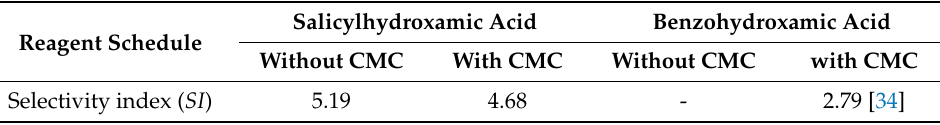
Figure 5. Froth phase images of mixed binary mineral flotation experiments after 0 ( a ) and 3 min ( b ) flotation. Table 1. Selectivity index ( SI ) values in different flotation reagent schedules.